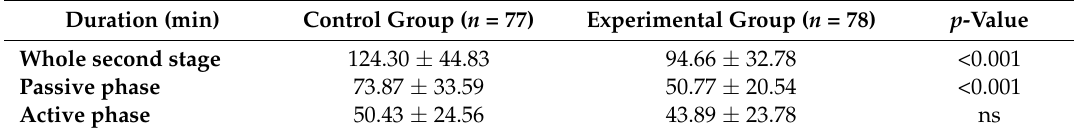
Table 4. Differences in the duration of the second stage of labor between